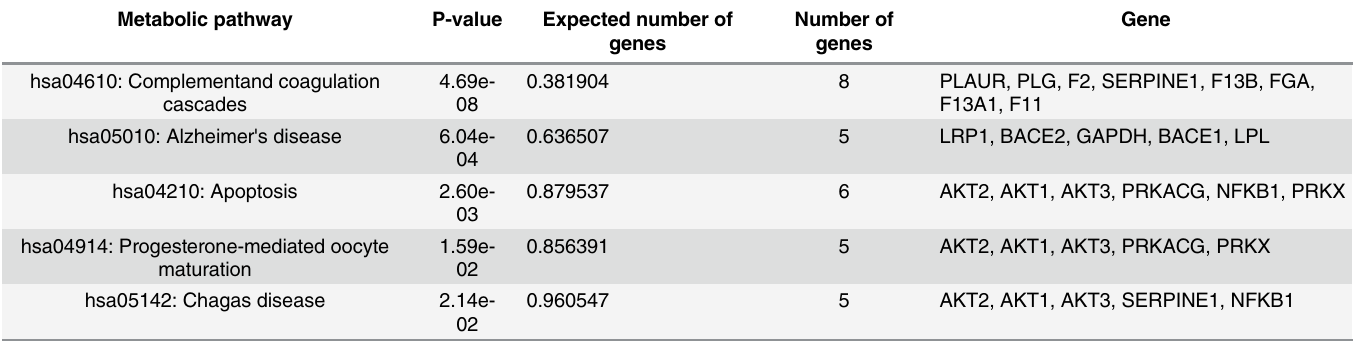
Table 4. Enrichment analysis of causal genes in Alzheimer